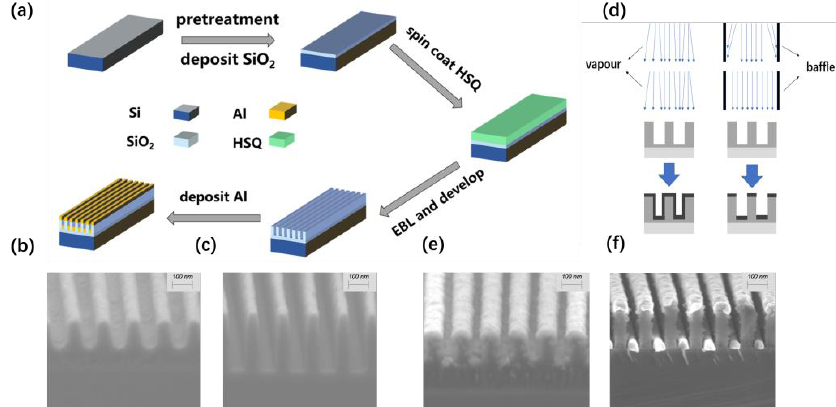
Figure 3. ( a ) The fabrication processes. ( b ) SEM images of gratings obtained using conventional developing. ( c ) SEM images of gratings obtained using hot developing. ( d ) Deposition without and with a baffle ( e ) Metal grating fabricated by deposition without a baffle. The bright area is metal, and the dark area is oxide. ( f ) Metal grating fabricated by deposition with a baffle. The bright area is metal, and the dark area is